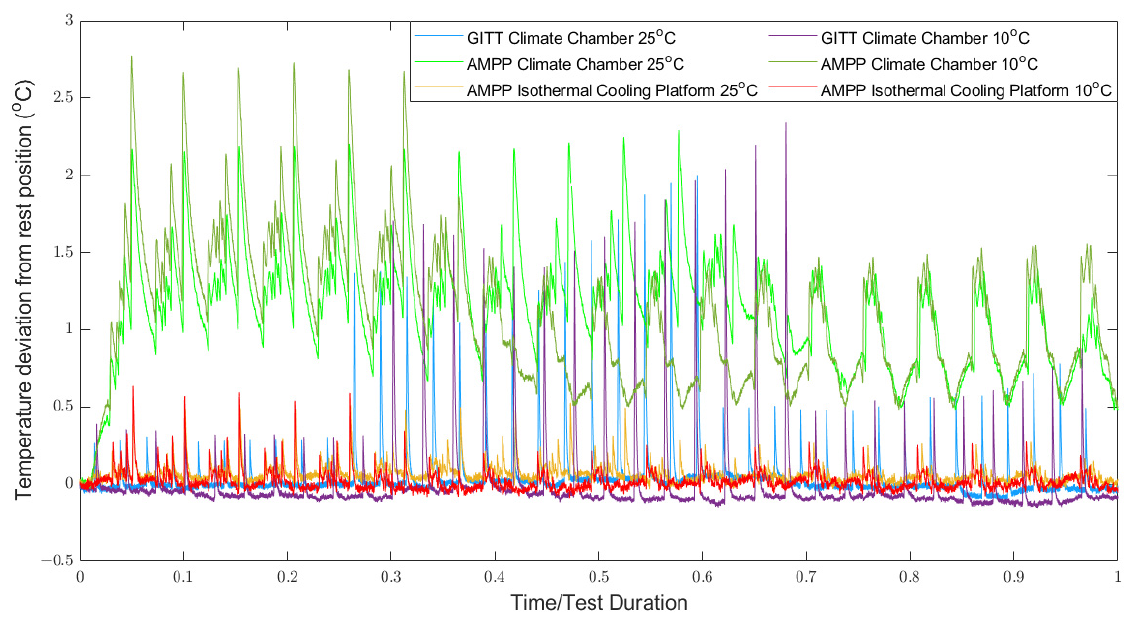
Figure 8. Temperature deviation from the rest position during the experiments used for parametrisation. Temperature was measured using type-K thermocouples.